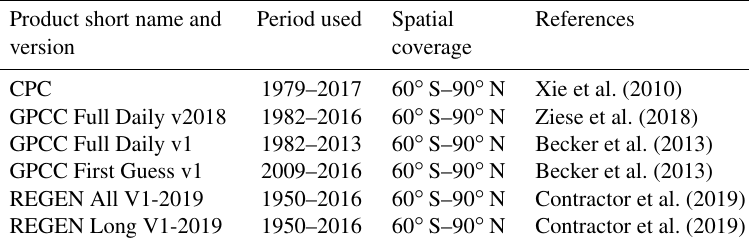
Table 1. The ground-based